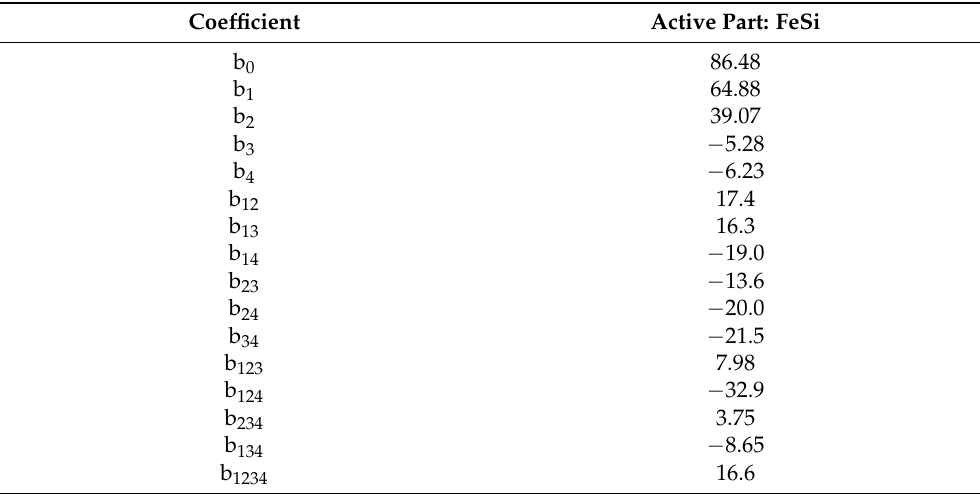
Table 3. The calculated values of the coefficients of the regression equations are coefficients of the experimental values mentioned in Table